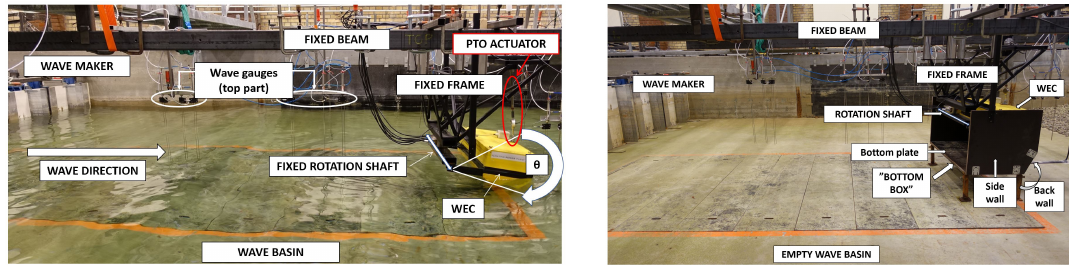
Figure 7. Left : Photo showing the WEC in the wave basin (“WEC only” setup). Right : Photo of the setup that consists of WEC and fixed substructure (“WEC+BB” setup). The location of the WEC is the same in both